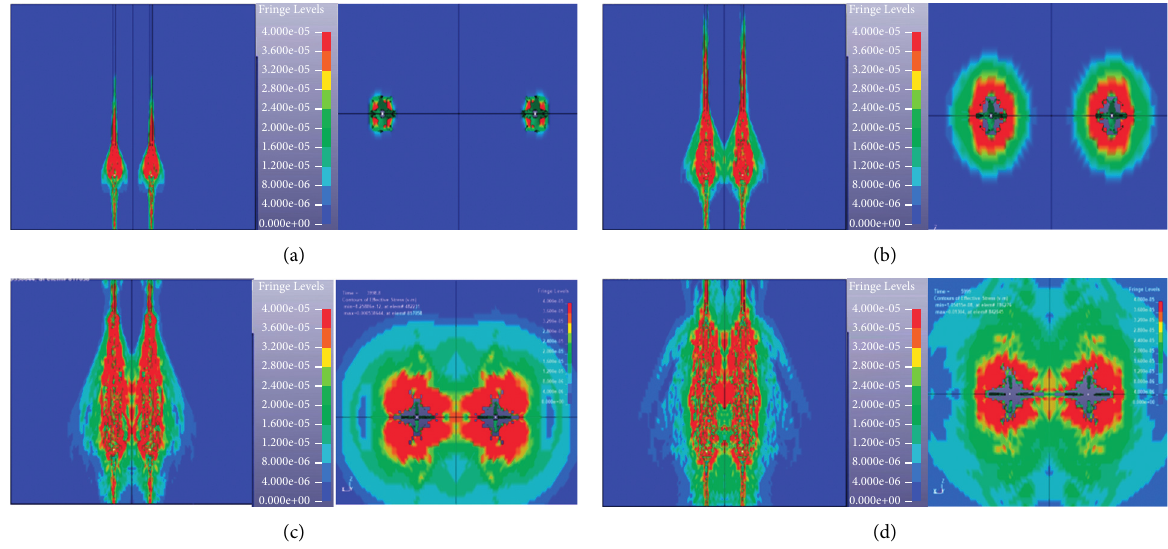
Figure 10: Stress nephograms of vertical section and lateral section of smooth blasting with mud-accumulated hydraulic pressure (unit: 10 5 MPa). (a) T � 1.00ms. (b) T � 2.00ms. (c) T � 4.00 ms. (d) T � 6.00ms.